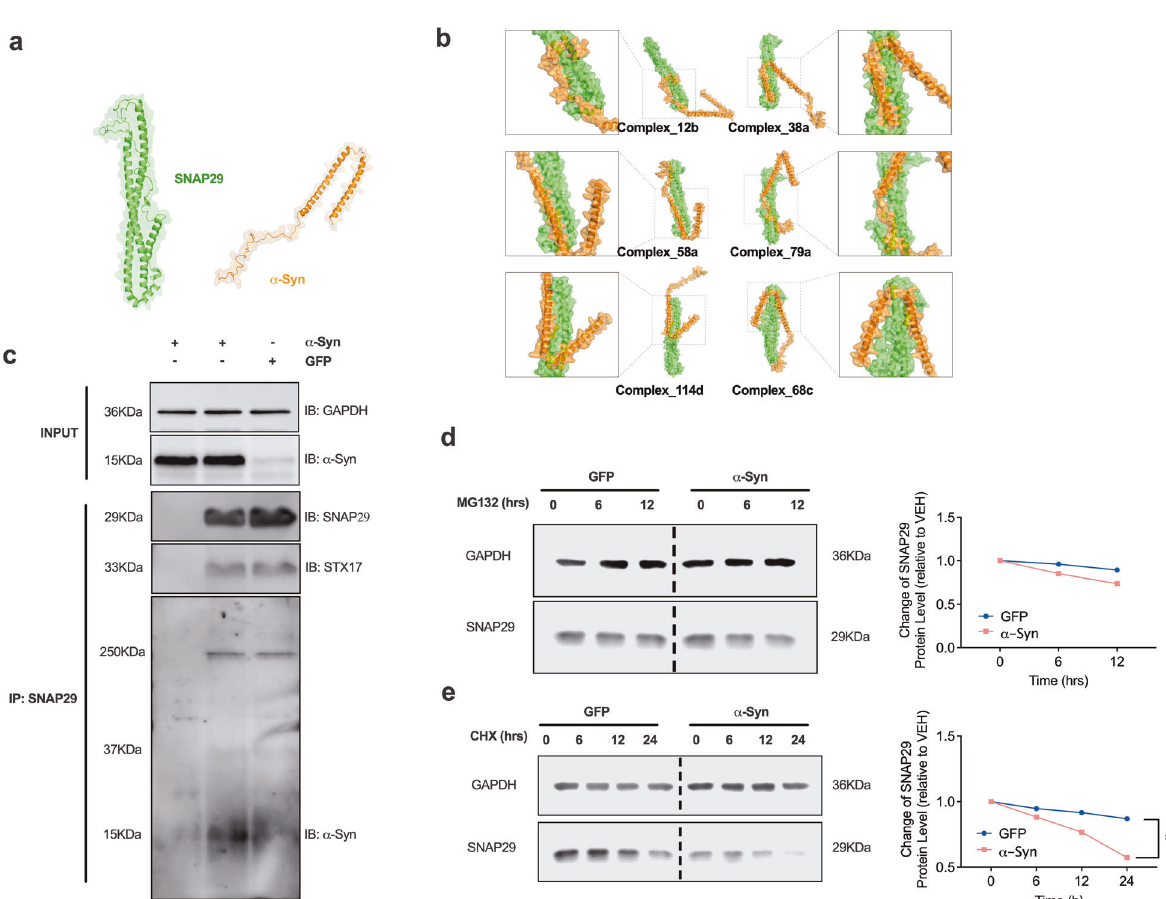
Fig. 6 Computational modeling and Co-IP suggest a physical interaction between α -Syn and SNAP29 in cultured neurons. a Schematic illustrating the computationally modeled tertiary structure of SNAP29 and α -Syn. b Schematic illustrating potential biding sites and complexes between SNAP29 and α -Syn. c Western blot illustrating the result of a Co-IP with SNAP29 as a bait. Reacting the membrane with an antibody against α -Syn revealed a clearly visible band in α -Syn-transduced neurons at around 15 kDa. The left lane represents a negative control (no SNAP29 antibody during IP). Representative result from 3 independent experiments. d Western blot and graph illustrating the change in SNAP29 protein levels in response to treatment (6 or 12 h) with the proteasome inhibitor MG132 (100 nM). E Western blot and bar graph illustrating the change in SNAP29 during treatment with the protein synthesis inhibitor cycloheximide (CHX; 100 μ g/ml). Note the reduced half-life of SNAP29 in the presence of CHX. For comparison of the means, a two-tailed unpaired t -test was used in panel d , e ; * P < 0.05. Data are shown as means ± into full chain models and 5 top-scored structure models were returned and optimized to increase the Rosetta score of these models. Among the fi ve SNAP29 models, #4 showed a good PROCHECK (Ramachandran plot: 95.2% most favored), Verify 3D (93.41% residues were in allowed regions), ERRAT (95.95), and ProSA analysis result ( z -score: − 6.49; Supplementary Fig. 3). These results con fi rmed the quality of our predicted model of SNAP29.